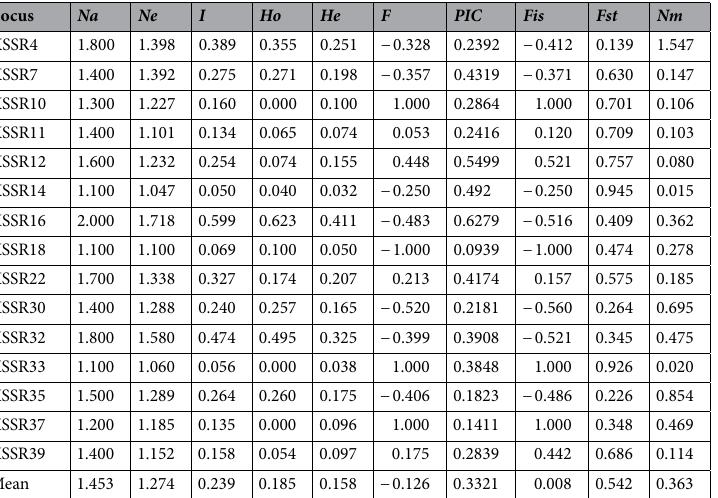
Table 1. Population genetic parameters of 48 samples representing 10 populations of Dactylorhiza hatagirea. Na = Number of Different Alleles, Ne = Number of Effective Alleles, I = Shannon’s Information Index, Ho = Observed Heterozygosity, He = Expected Heterozygosity, F = Fixation Index, PIC = Polymorphic Information Content, Fis = Inbreeding coefficient among individuals within population, Fst = Average genetic differentiation coefficient, Nm = Gene Flow.